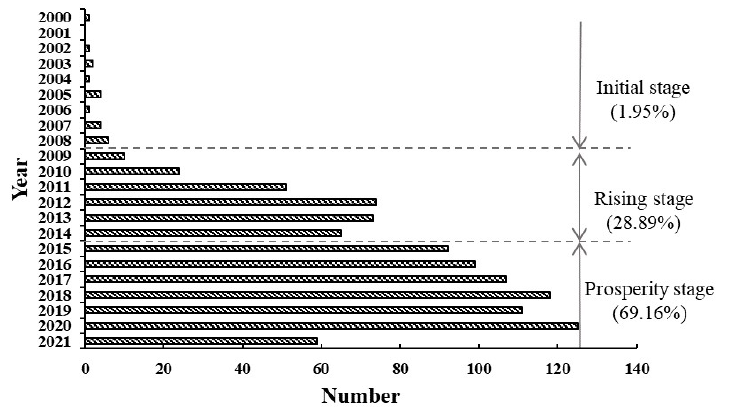
Figure 2. Annual changes in the number of residential carbon emissions publications from 2000 to